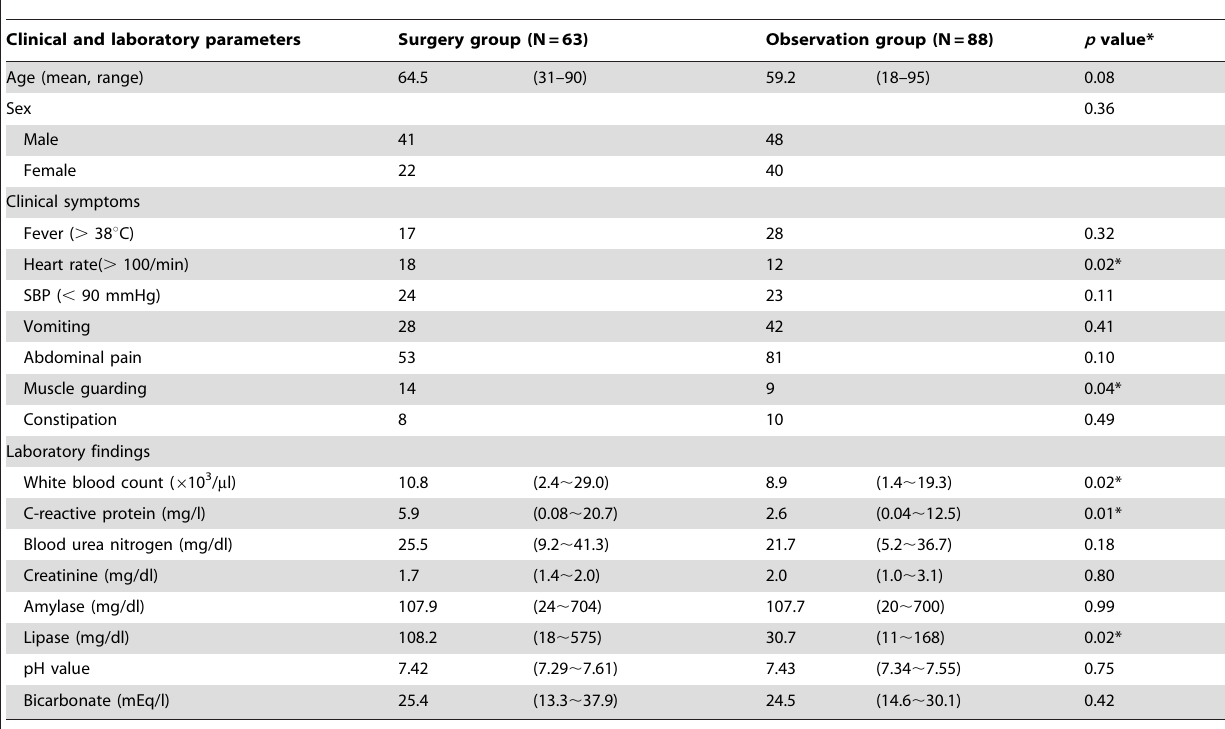
Table 1. Comparison of clinical and laboratory parameters in the surgery and observation groups.